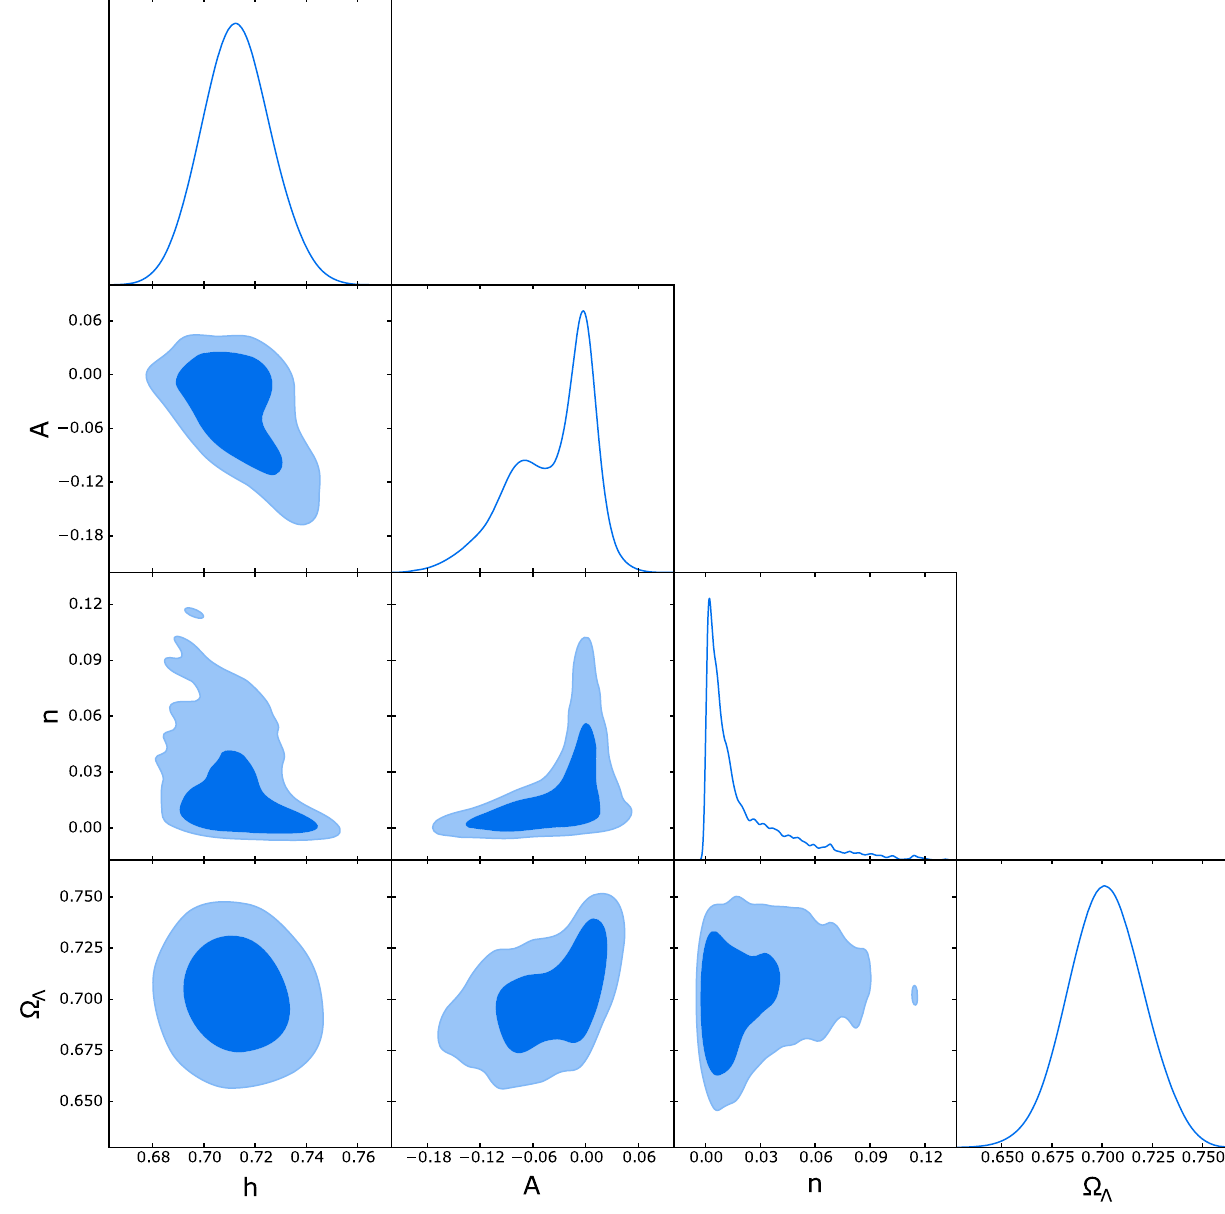
Fig. 2 One-dimensional marginalized distribution, and two-dimensional contours with 68 and 95% confidence level for the free parameters of the model BAO : The baryon acoustic oscillations (BAOs) are another important probe. We use the BAO measurements from the Six Degree Field Galaxy Survey (6dF) [51], the Main Galaxy Sample of Data Release 7 of Sloan Digital Sky Survey (SDSS-MGS) [52], the LOWZ and CMASS galaxy sam- ples of the Baryon Oscillation Spectroscopic Survey (BOSS- LOWZandBOSS-CMASS,respectively)[53],andthedistri- bution of the LymanForest in BOSS (BOSS-Ly) [54]. These data points are summarized in Table I of